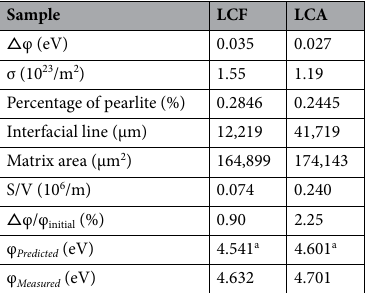
Table 3. Detailed data (e.g., interfacial charge density, S/V, etc.) used in model calculations. a The work function of iron is 4.5 eVs 48